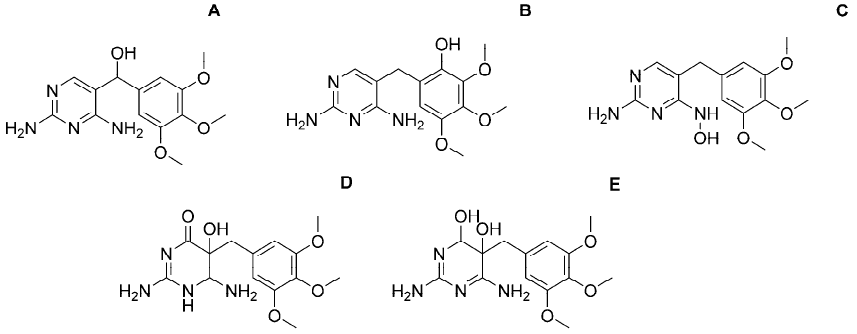
Figure 2. Tentative molecular structures for TRI transformation products according to previous studies. ( A – C ): Proposed structures for OP306. ( D , E ): Proposed structures for OP324.